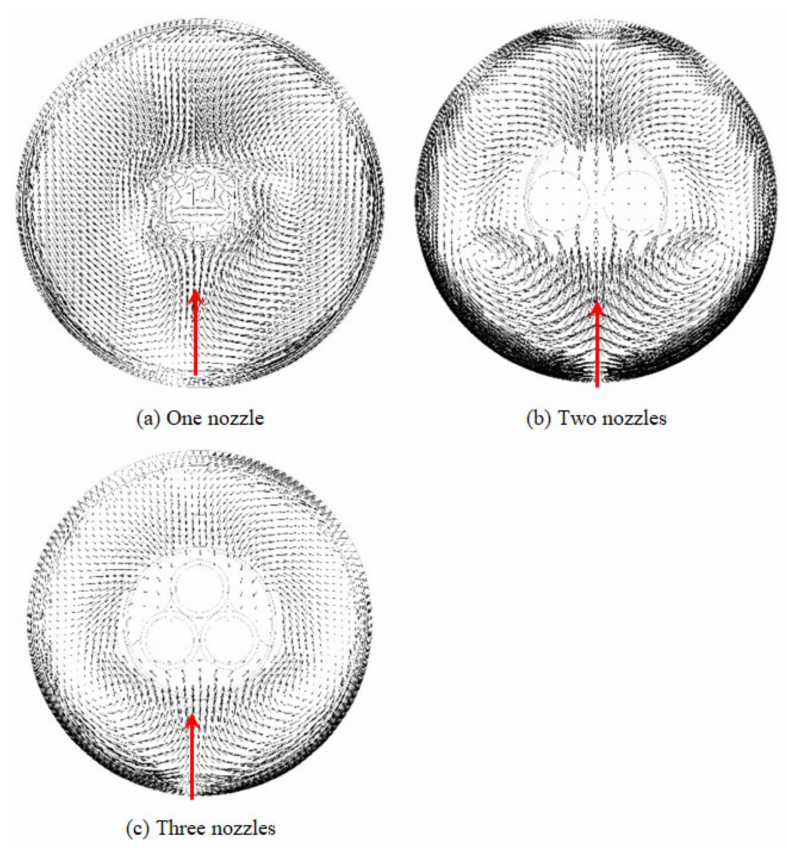
Figure 15. Flow vector at 62